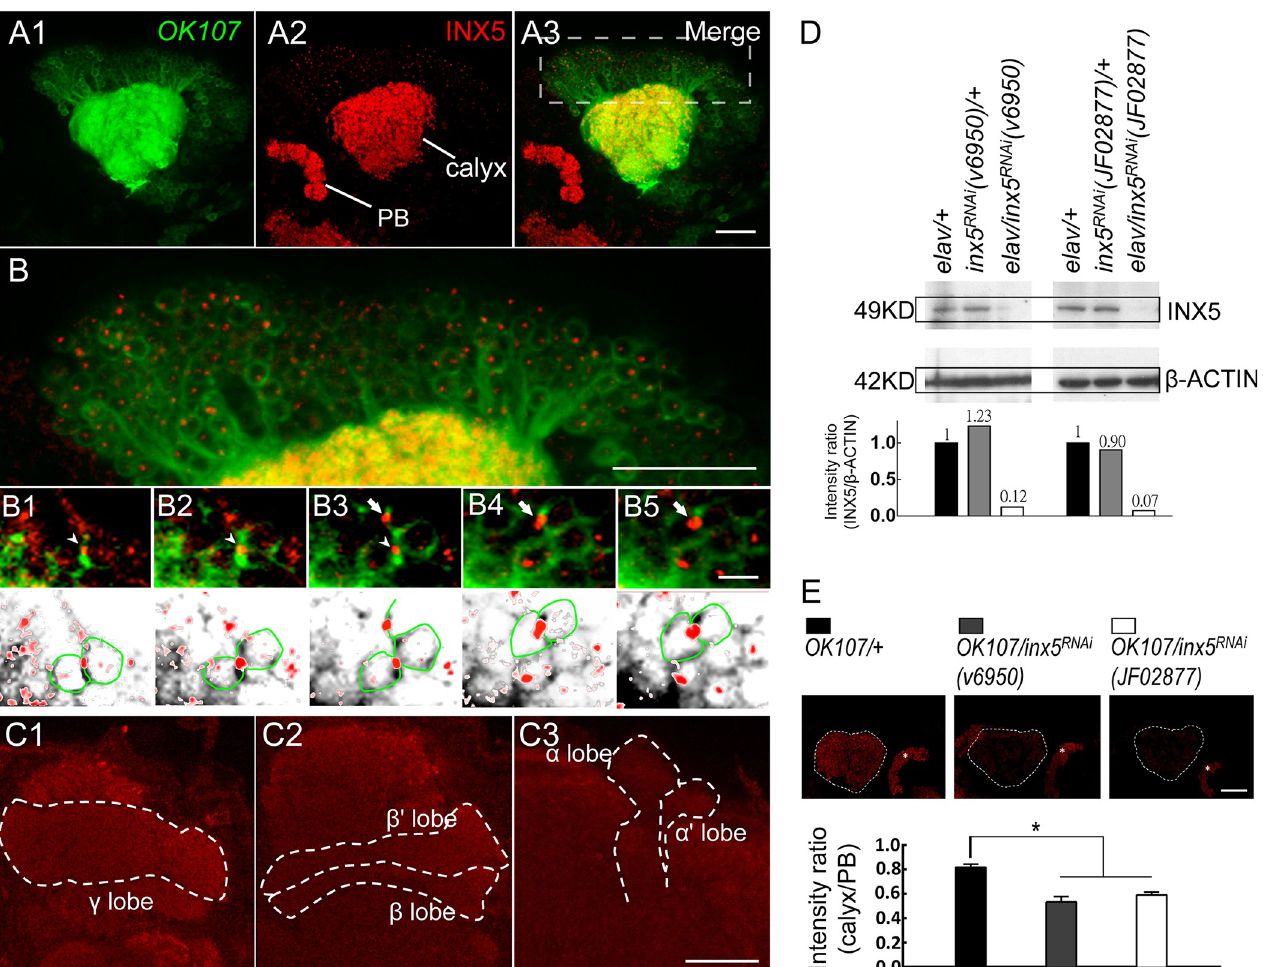
Fig 2. INX5 is expressed in MBs. The OK107-GAL4 -driven expression of a UAS-mCD8 :: GFP; UAS-mCD8 :: GFP reporter (green) in the MBs is shown (A1). Whole-mount adult brain immunostaining of INX5 (red) showed the preferential expression of INX5 in the calyx and protocerebrum bridge (PB) (A2). The merged images show the overlap (yellow) of INX5 staining (red) and GFP reporter (green) in the MB calyx (A3). (B) An enlarged image of the MB neurons (A3), which indicates preferential expression of INX5 in the somas of MB. The scale bar represents 20 μ m. (B1-B5) Serial sections show an enlarged confocal image of MB neurons. INX5-positive dots were intercalated in the membrane between MB neurons (arrowheads and arrows) and relatively weak INX5 expression in the nucleus. The genotype in (A-B) was as follows: +/UAS-mCD8 :: GFP; +/UAS-mCD8 :: GFP; OK107-GAL4/+ . The scale bars represent 10 μ m. (C) The INX5 immunostaining signals (red) in distinct lobes of MB neurons. Each lobe showed relatively weak INX5 immunostaining compared to the MB calyx and protocerebrum bridge (also see S2 Fig). The scale bars represent 20 μ m. (D) Western blot validation of the specificity of the INX5 antibody and the effectiveness of the UAS-inx5 RNAi effectors driven by pan-neuronal elav-GAL4 . The genotypes were as follows: (1) elav-GAL4/+; +/+; +/+ , (2) +/+; UAS- inx5 RNAi (v6950)/+ , (3) elav-GAL4/+; +/+; UAS-inx5 RNAi (v6950)/+ , (4) +/+; UAS-inx5 RNAi (JF02877)/+ , and (5) elav-GAL4/+; +/+; +/UAS-inx5 RNAi (JE02877) . (E) Quantitative INX5 immunostaining. All images were taken with the same settings. The intensity ratio of INX5 staining represents the difference between the MB calyx and protocerebrum bridge. The scale bars represent 20 μ m. Each value represents the mean ± SEM (n = 9–10). � , p < 0.05; one-way analysis of variance followed by Tukey’s test. The genotypes were as follows: (1) +/+; +/+; OK107-GAL4/+ , (2) +/+; UAS-inx5 RNAi (v6950)/+; OK107-GAL4/+ , and (3)